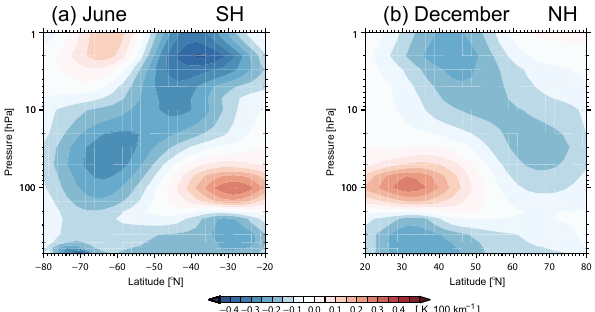
Figure 4. Meridional sections of the climatological poleward tem- perature gradient around the winter solstice: (a) SH June, (b) NH December.